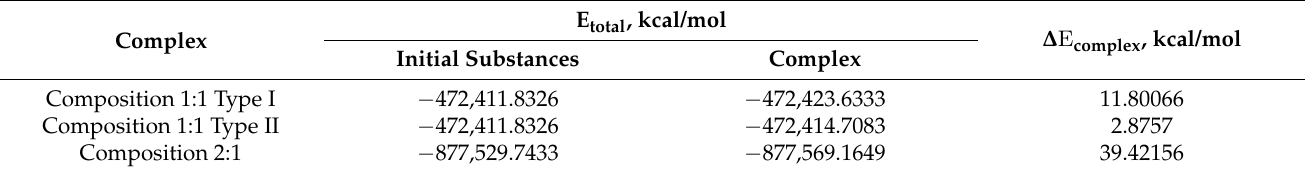
Table 1. Calculated values of the complexation energy of the studied inclusion complexes of β -CD: resveratrol.